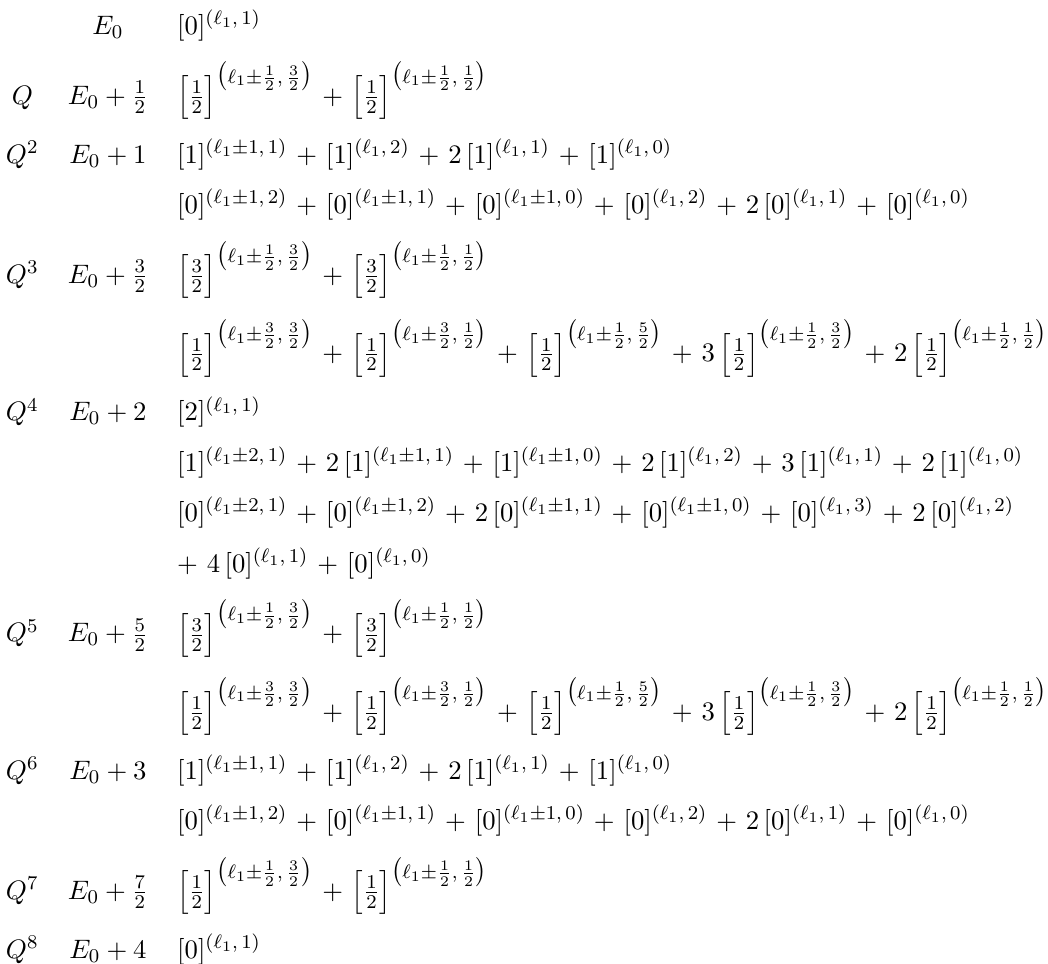
Table 11 . States in the long graviton supermultiplet LGRAV 4 [ E 0 , ‘ 1 , 1] , with ‘ 1 ≥ 3 the negative Dynkin label at the Q 4 level is